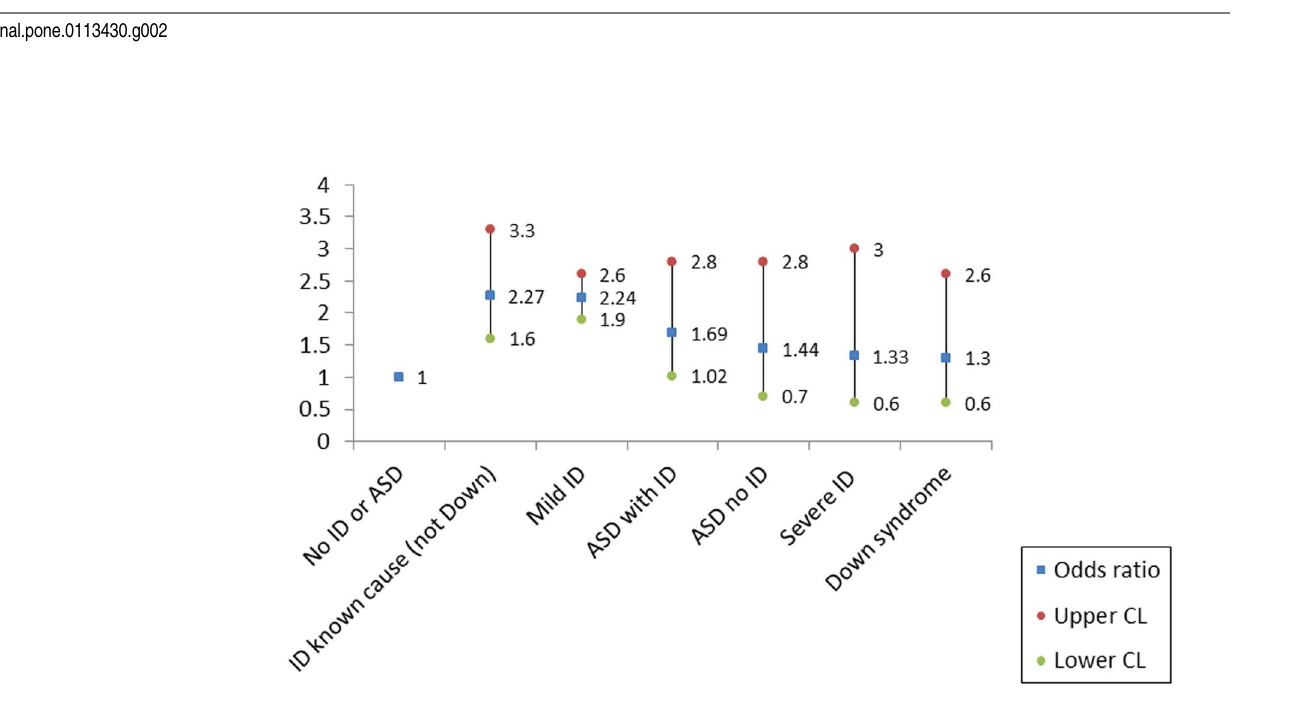
Fig. 3. Adjusted* hazard ratios for death by maternal case group.